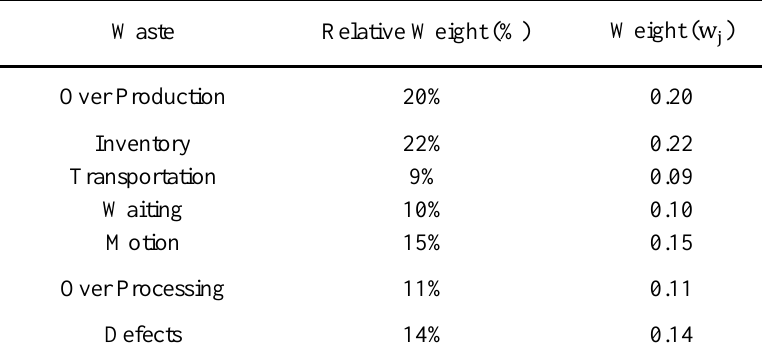
Table 1. Relative weight (w j) of seven